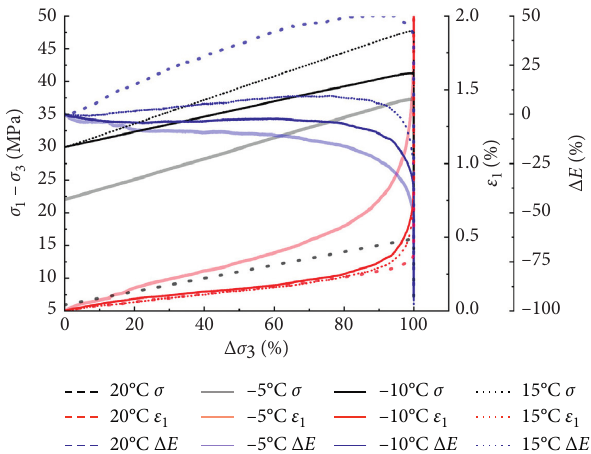
Figure 10: The relationship between sandstone Δ σ mation at different temperatures ( σ 0